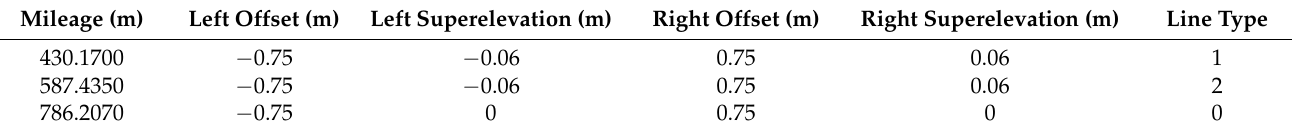
Table 3. Example of superelevation